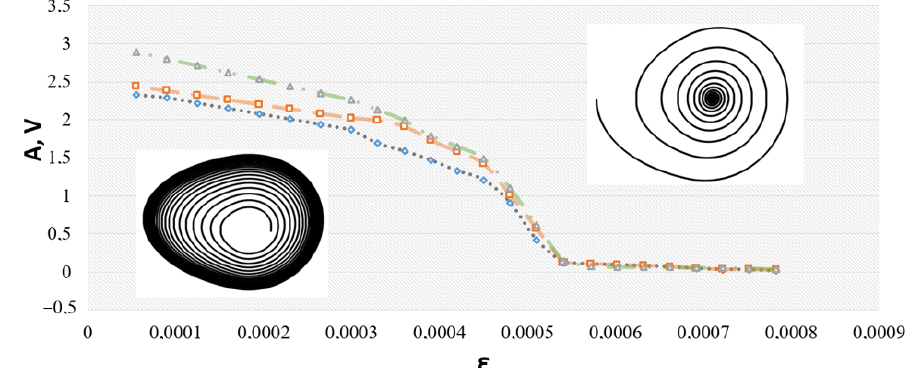
Figure 10. One–parameter bifurcation diagram with a device area of 5 × 5 µ m 2 . The grey, orange and green dependencies are determined by y 1 , y 2 , and y 3 initial conditions, respectively.